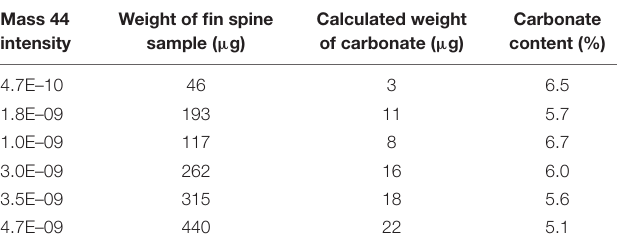
TABLE 1 | Evaluation of carbonate contents in fin spine bone powder.